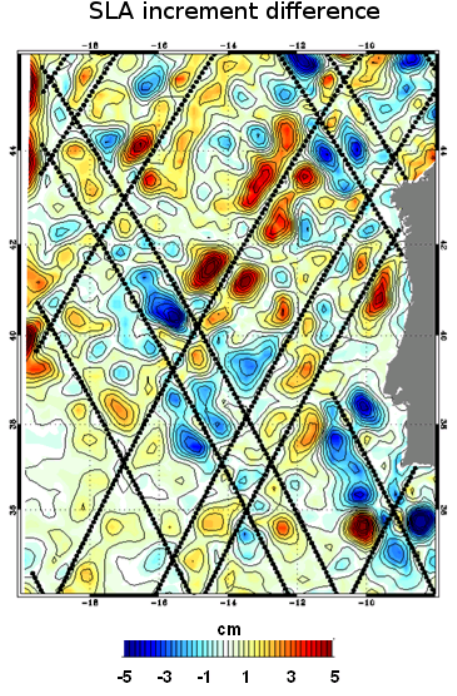
Figure 13. SLA increment difference using 10 and 300 Shapiro passes as anomaly filtering in a regional system at 1 / 36 ◦ . The black lines represent the position of the assimilated altimeter tracks. Unit is